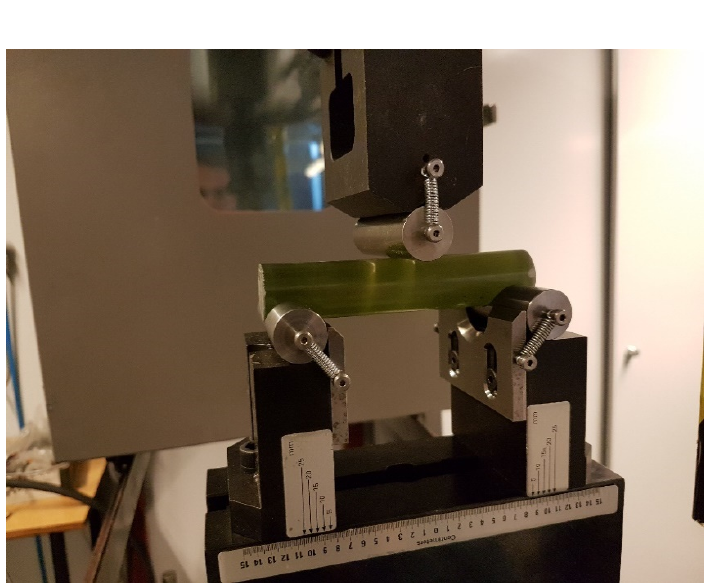
Figure 4. The sample of a group A from HVAC composite insulator carrying rod in a mechanical system for strength testing via the 3-point bending test. The notches in bottom supporting rollers are visible.